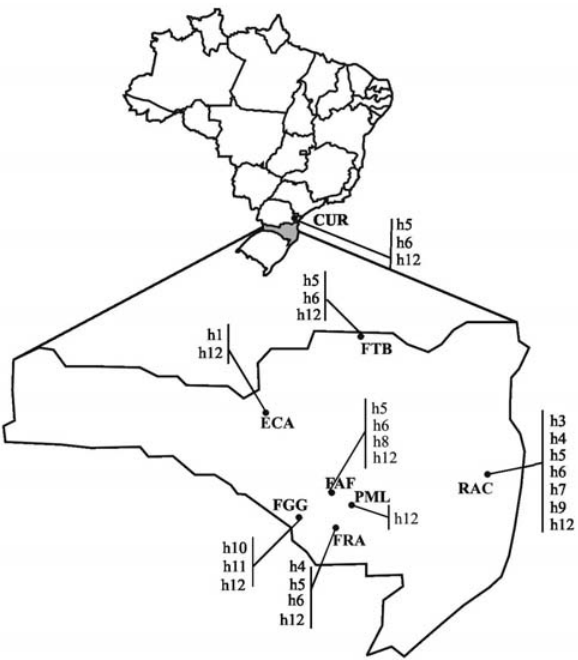
Figure 1 - Geographic location of the sampled populations in Santa Catarina State (Brazil) and the haplotype distribution. PML = Parque Mu- nicipal de Lajes, FTB = Flona de Três Barras, FRA = Fazenda Rancho Alegre, ECA = Estação de Caçador, FGG = Fazenda Guamirim Gateados, RAC = Reserva do Caraguatá/Antônio Carlos, FAF = Fazenda Amola Faca.h1-h12=haplotypenames.SeeTable1forLongitudeandlatitudeof each